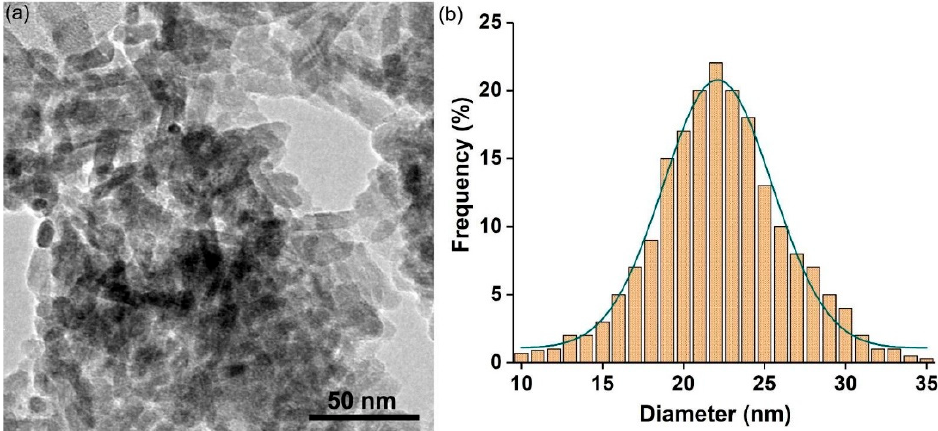
Figure 2. TEM micrographs ( a ) and particle size distribution ( b ) specific to 5EuHAp suspensions. Figure 3 revealed X-ray diffractograms of the 5EuHAp powder (a) and 5EuHAp thin film (b). The crystallite sizes and lattice parameters of the HAp phase obtained for the